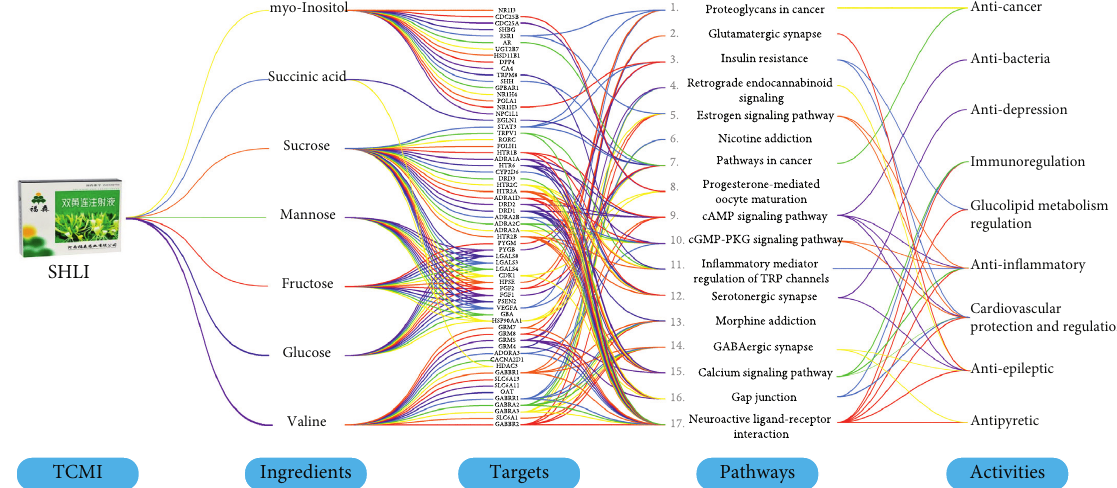
Figure 4: Parallel coordinate plot for the ingredients-targets-pathways-activities network of the focused primary metabolites from SHLI. Table 2: Chemical shift and signals assignment of quantitative protons for seven primary metabolites. Primary metabolites